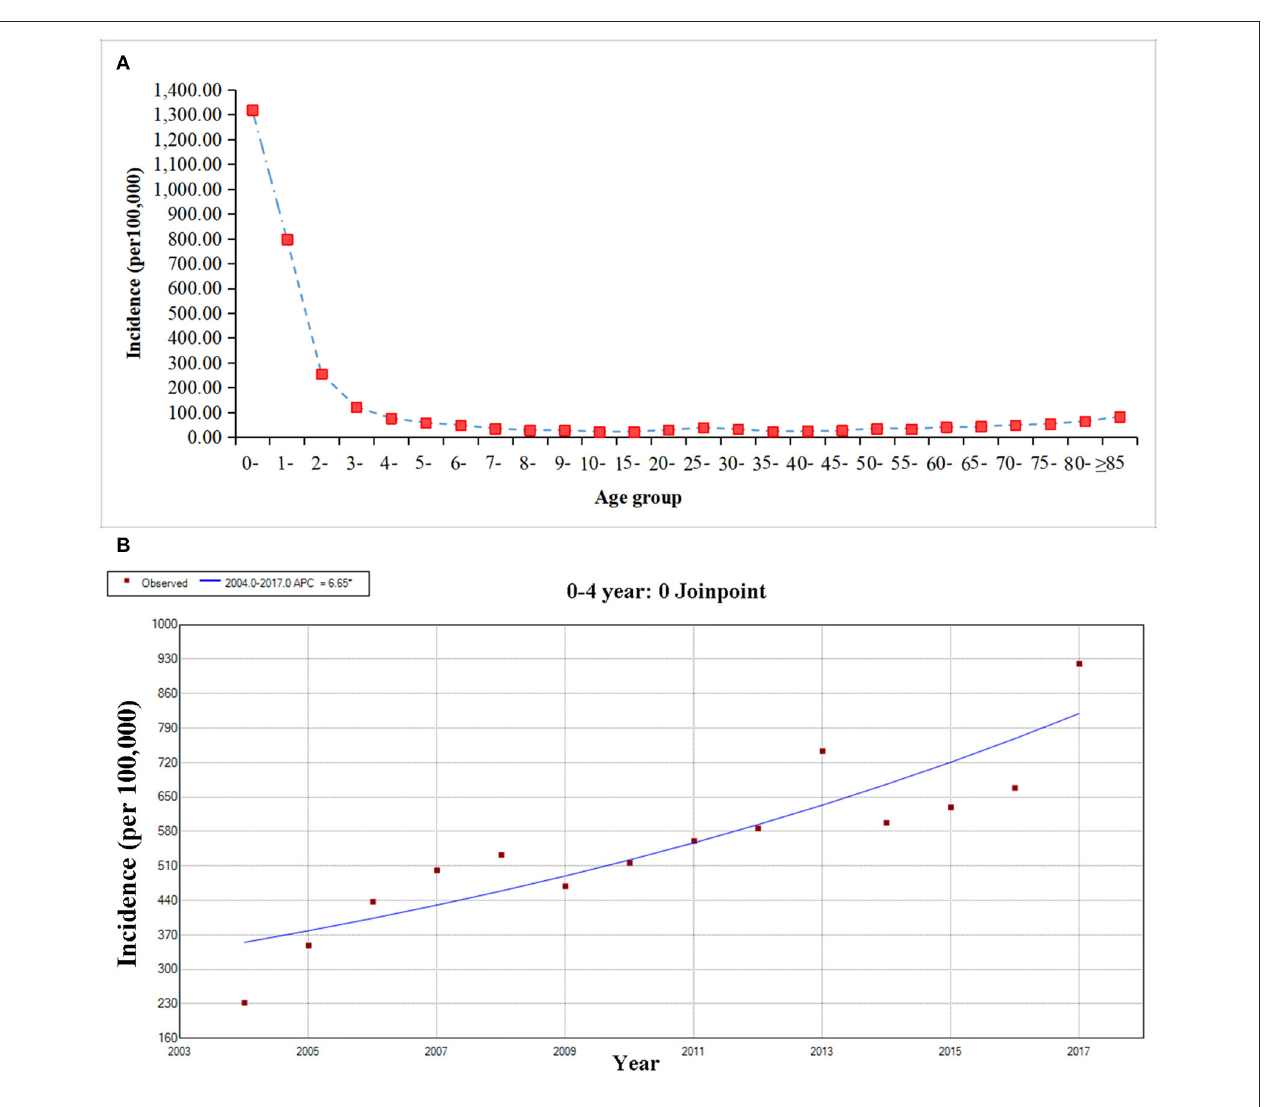
FIGURE 2 | The age group distribution and trend of other infectious diarrhea from 2004 to 2017. (A) The age group distribution of OID. (B) The Joinpoint analysis of OID in the age of 0–4 year.